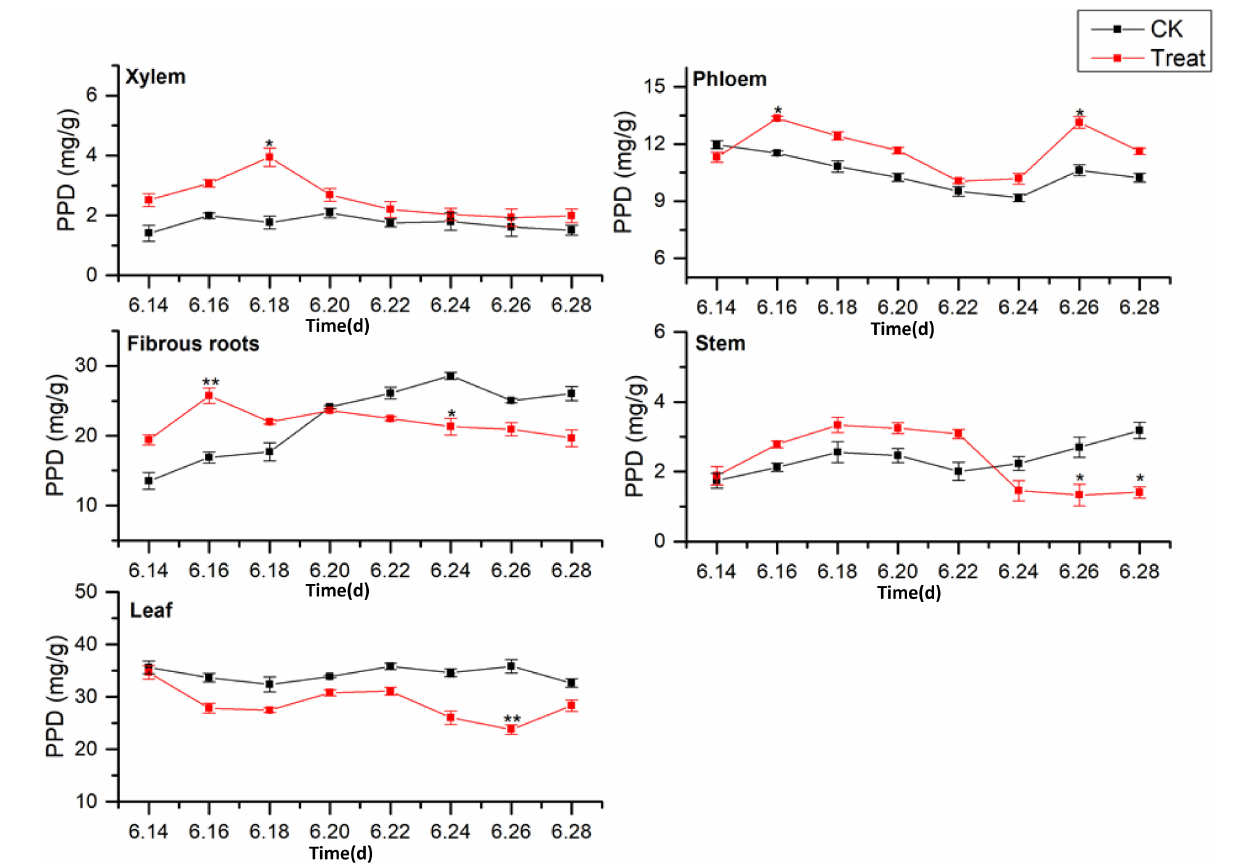
FIGURE 7 | Effects of cold stress on the PPD ginsenoside content in different tissues of flowering ginseng. The X axis represents the sampling time. * p < 0.05 and ** p < 0.01, compared with control group. The data are expressed as the mean ± SD ( n =